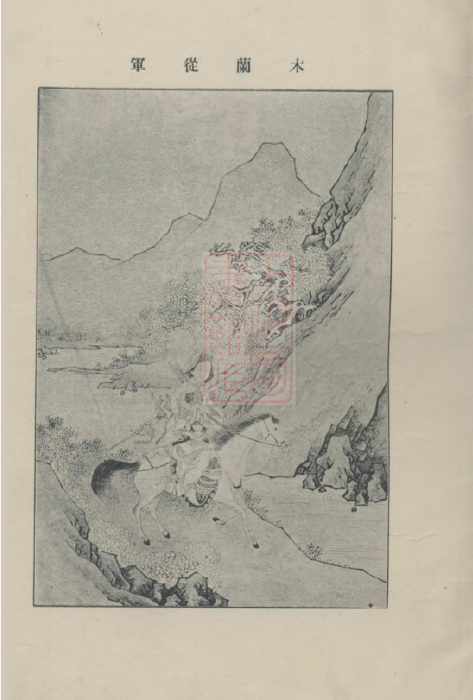
Figure 1. A painting entitled “Mulan Joins the Army (Mulan congjun)”, published as an illustration for the biography of Mulan written by Liu Yazi. ( Women’s World , no. 3, 1904).